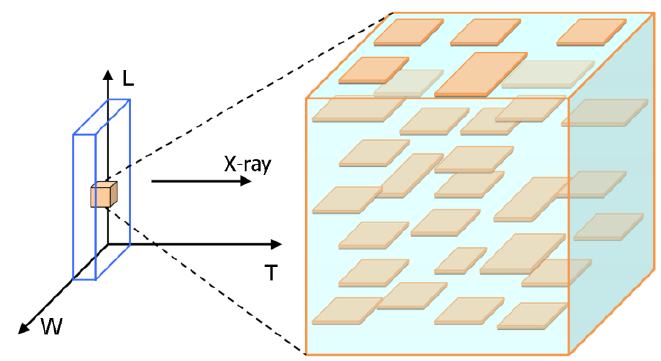
Figure 3. Schematic diagram of shape and distribution of nano-scale defects in RDX and HMX single crystal .